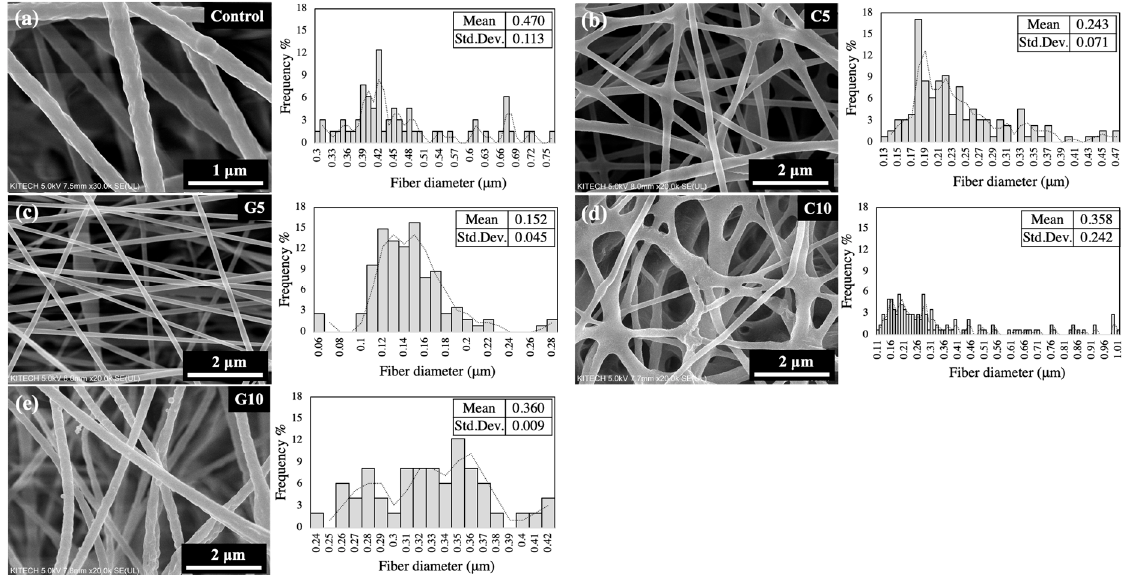
Figure 2. The morphology and nanofiber diameter distributions of electrospun webs with different concentrations of monoterpenoids: ( a ) control, ( b ) C5, ( c ) G5, ( d ) C10, and ( e ) G10.